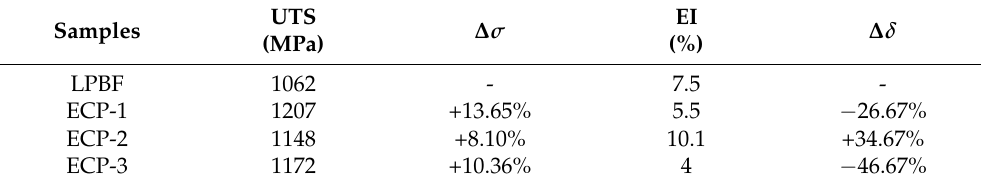
Figure 9. Mechanical properties of the LPBF-Ti64 samples before and after ECP treatment. Table 8. Mechanical properties and its change rate of the LPBF-Ti64 samples before and after ECP treatment.